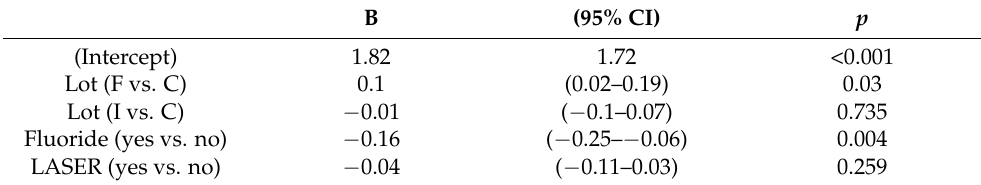
Table 4. Multivariate model coefficients: Dp.